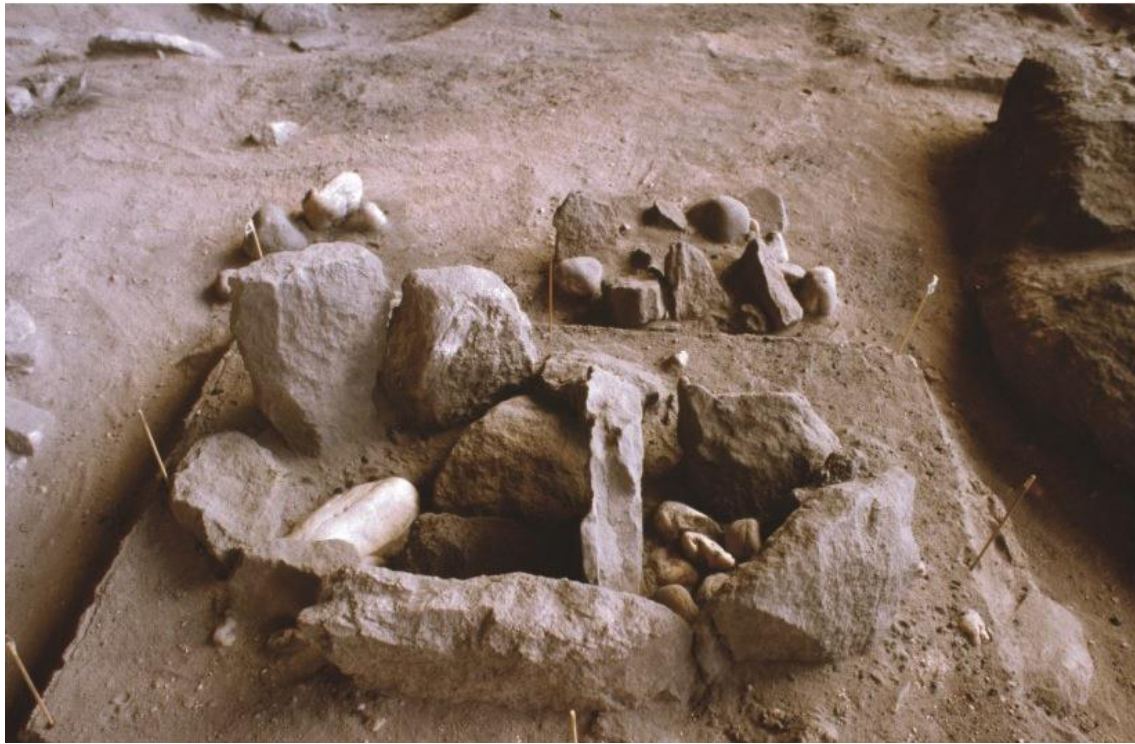
Figure 11. Hearth 32, sector 3, 8,804+/-53 (LY 10138) (Photo by Fumdham